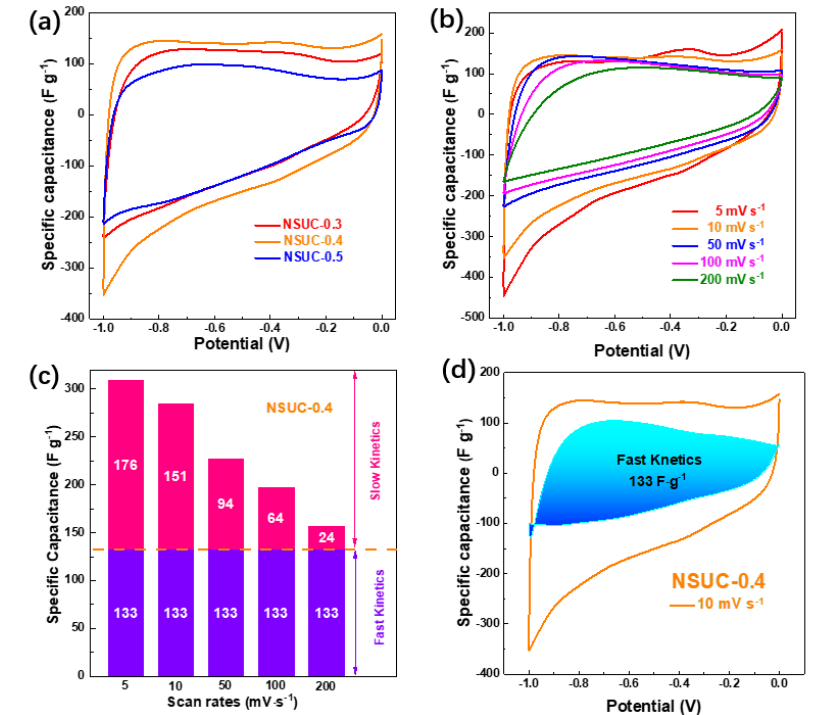
Figure 5. ( a ) CV curves at 10 mV s − 1 , ( b ) CV curves of NSUC ‐ 0.4 at different scan rates, ( c ) histogram of capacitance contribution and ( d ) decoupling capacitance from slow ‐ kinetic processes (blank) and fast ‐ kinetic processes (blue region).